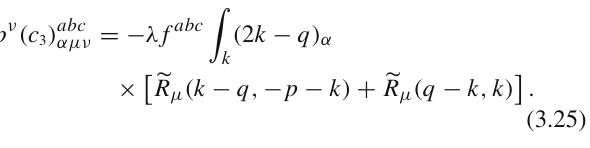
Fig. 4 The three contributions which emerge from the diagram ( c shown in the Fig. 2, after implementing the skeleton expansion of the four-point scattering kernel (purple blob) formed by two background gluons with a ghost–antighost